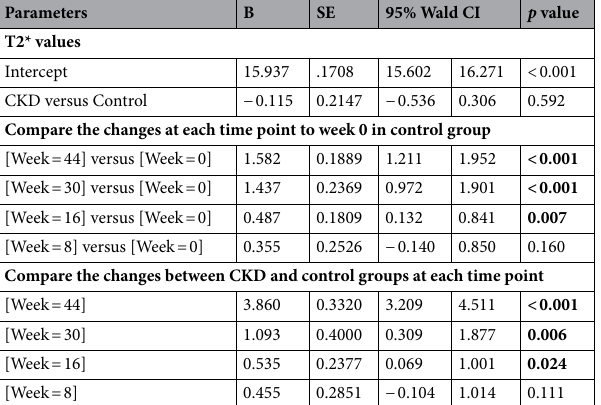
Table 5. Comparisons of T2* values between control and CKD groups over 44 weeks by GEE multiple linear regression. B: regression coefficient.